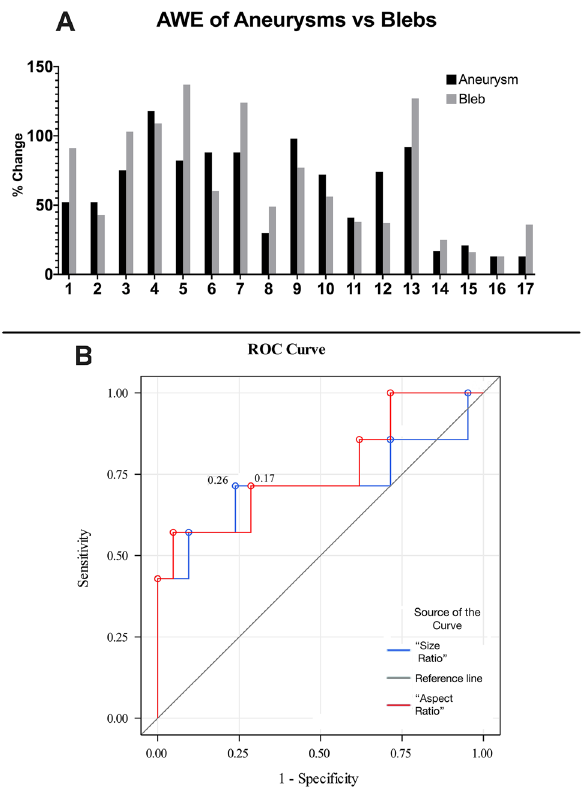
Figure 7. ( A ) Gd uptake of the aneurysm sac and its bleb (CC ratio ≥ 1). Fourteen aneurysms had blebs, and three aneurysms had two blebs (1 & 2, 6 & 7, 16 & 17). Gd bleb uptake varied within the same aneurysm. Overall, blebs exhibited more enhancement than sacs. ( B ) GAWE ROC analysis (CC ratio ≥ 1). Aspect ratio ≥ 3.56 (specificity 95%, sensitivity 57%) and size ratio ≥ 2.89 (specificity 76%, sensitivity 71%) best predicted GAWE + aneurysms. GAWE general aneurysmal wall